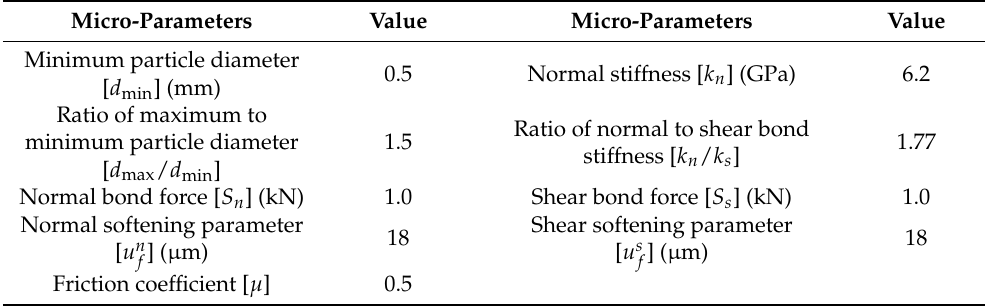
Figure 12. Experimental and simulation results of notched mortar beam. 5.1. Effect of Stiffness Three different stiffness values (